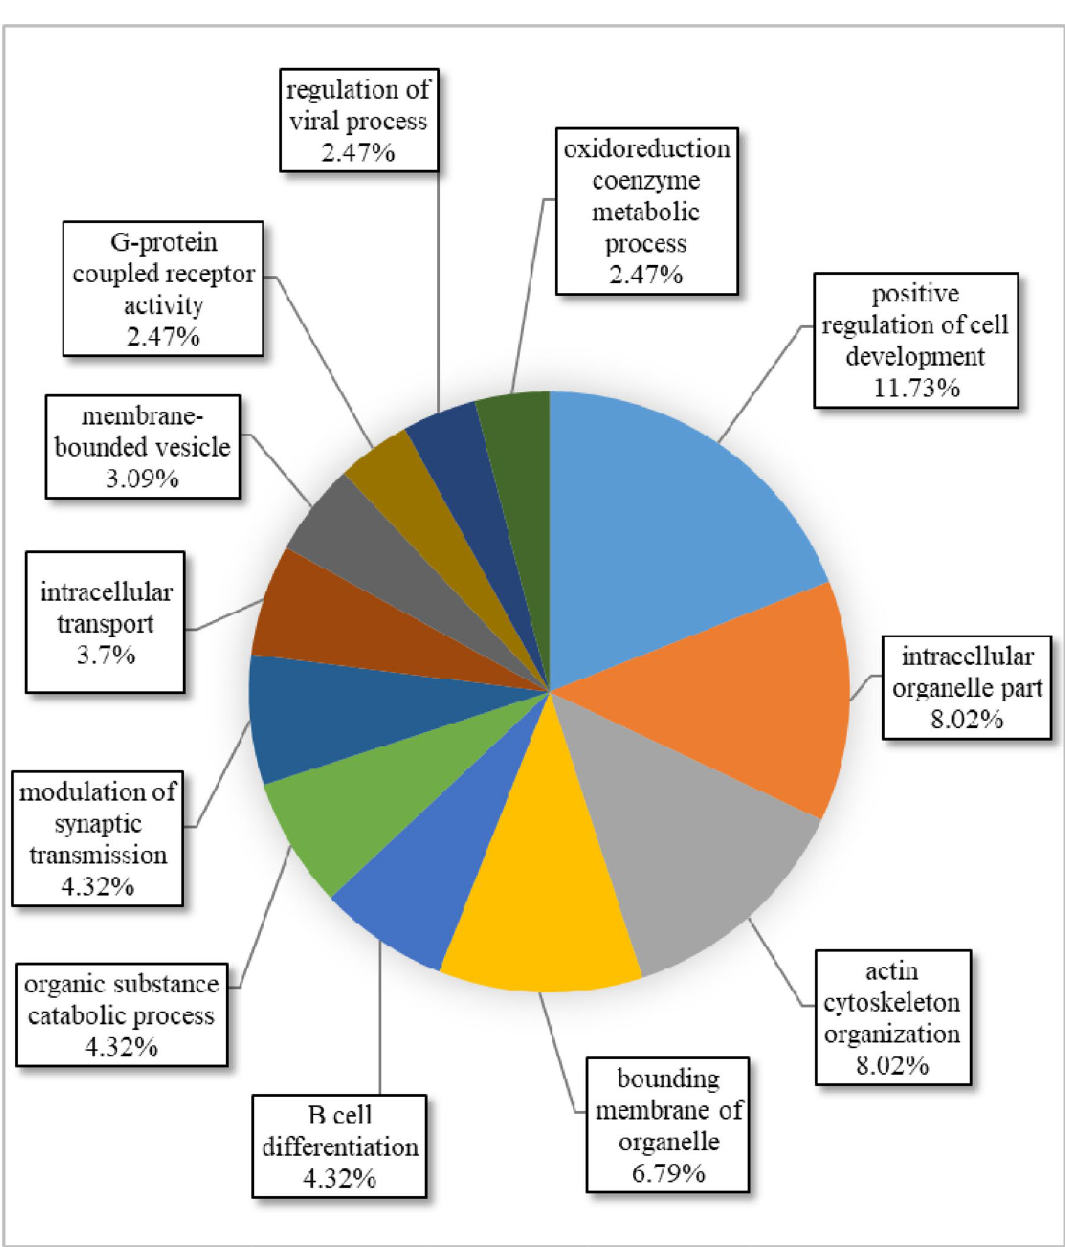
Figure 4. Circular diagram of the biological pathways involved by the genes reported in CNV-containing regions of all Afghan sheep breeds produced by Cytoscape functional annotation tool (http:// www. cytos cape. org/): in this figure, the name of each process and the degree of the gene participation have been reported. The pathways with a participation rate of less than 2% are not